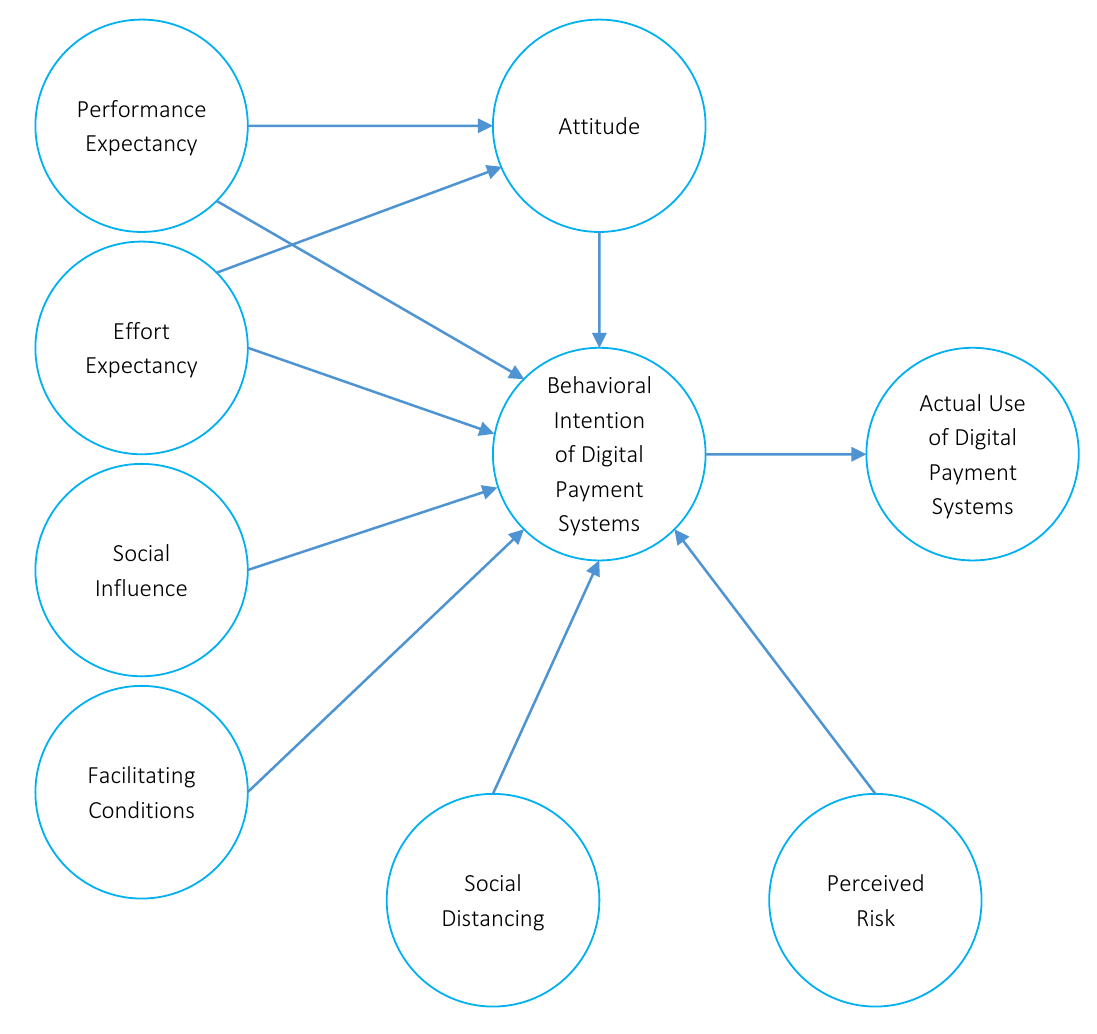
Figure 1. Conceptual